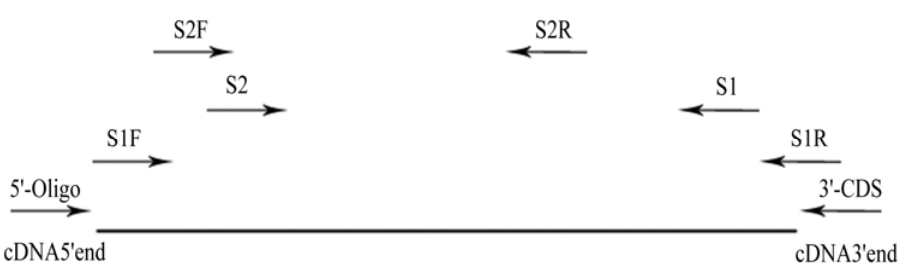
Figure 7. The position of primers used for PCR ampli fi